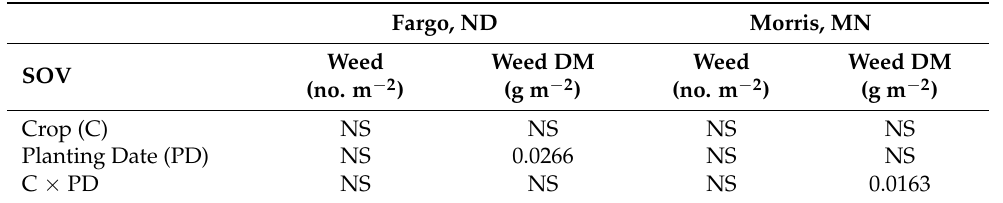
Table 2. ANOVA table showing level of significance ( p -values) for weed counts (no. m − 2 ) and dry matter (DM g m − 2 ) at Fargo, ND and Morris, MN field sites.